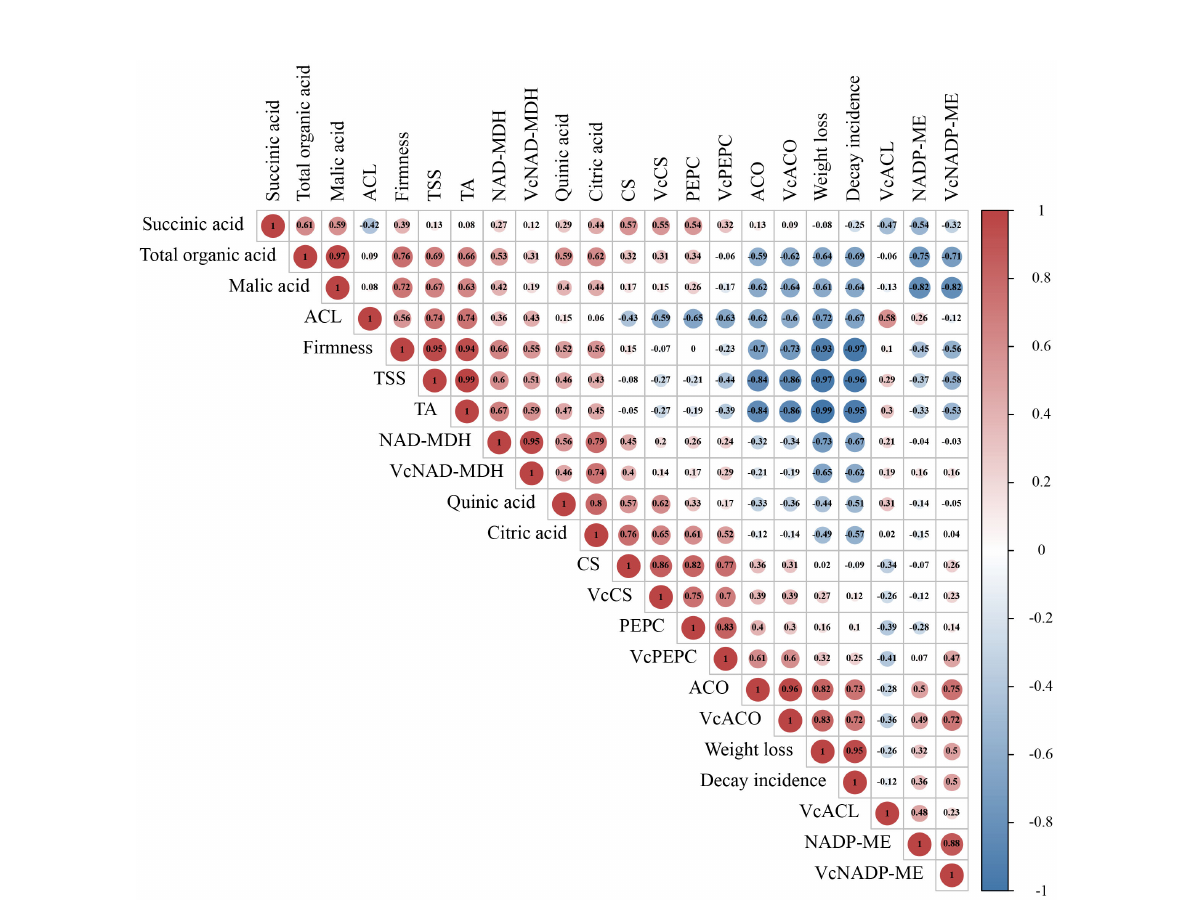
FIGURE 5 Correlation analysis of indicators involved in organic acid metabolism. The Correlation in all indicators was conducted by Pearson Correlation Analysis. The value in the circle represents the Pearson correlation coef fi cient between the heading of the column and the row. The closer the value is near to 1 or -1, the greater the correlation. Red color represents positive correlation; blue represents negative